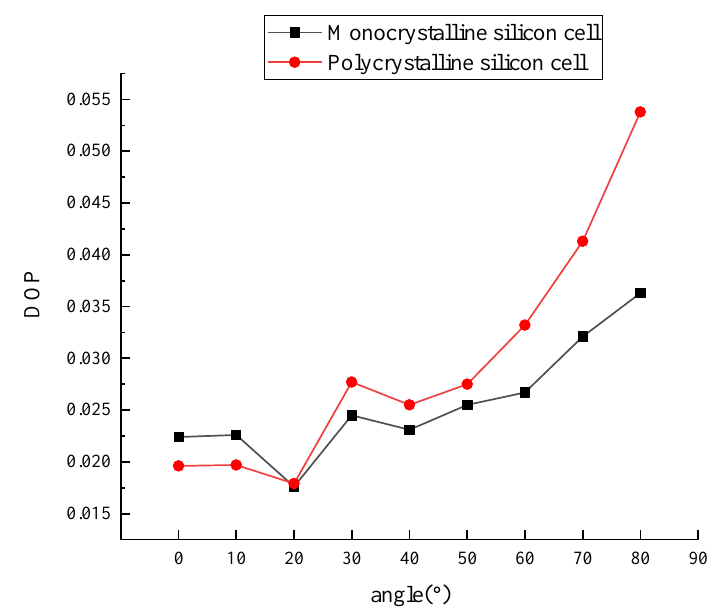
Figure 21. Curves of DOP value with view angle.